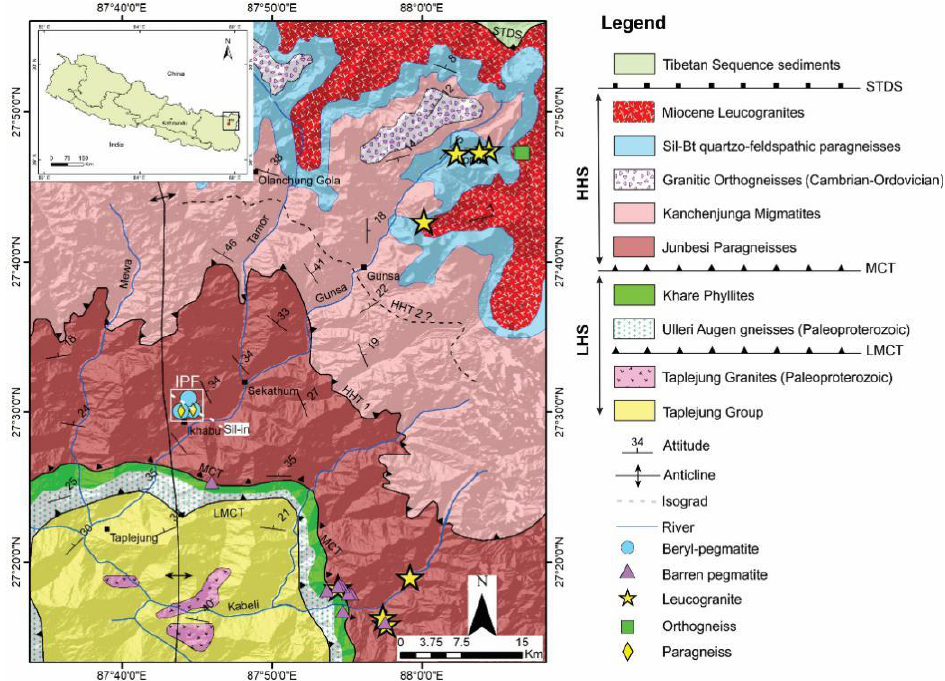
4 of 32 Figure 1. Regional Geological Map of Tamor–Kanchenjunga region, Eastern Nepal, showing the Ikhabu Pegmatite Field (IPF) and sample locations (compiled after [4–6,8]. Lower data clusters show the Chyanthapu area, and upper data clusters show the Kanchenjunga area. Abbreviations: LHS, Lesser Himalayan Sequence; HHS, Higher Himalayan Sequence; LMCT, Lower Main Central Thrust; MCT, Main Central Thrust; HHT, High Himal Thrust (HHT-1, HHT of [4]; HHT-2, HHT of [5]); STDS, South Tibet Detachment System; Bt, biotite; Sil, sillimanite. Mineral abbreviations are after [10]. The Kangchenjunga Migmatite has a gradational boundary with the overlying Kanchen- junga Paragneiss (Formation III) (Schelling, 1992). The Kanchenjunga Paragneiss formation is a 3–6 km thick unit consisting of Bt-Sil-gneiss/schist, quartzite, and widespread in- trusions of Cambrian–Ordovician granites (510–480 Ma, now orthogneiss) [7,11–13] and Miocene (23–12 Ma) leucogranite sills and dikes [14–16] (Figures 1 and 2a–d).